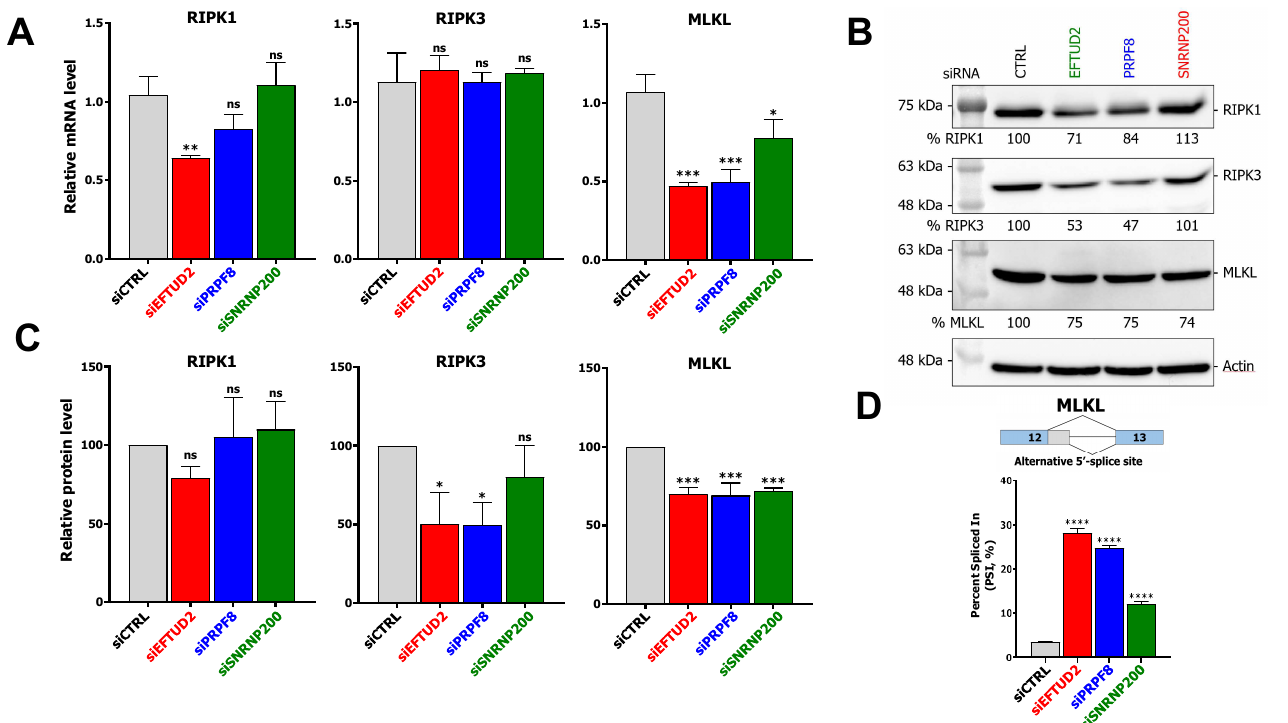
Figure S4). These results establish U5 snRNP proteins EFTUD2, PRPF8, and SNRNP200 as important for the regulation of the mRNA levels, the protein levels, and the AS of key necroptotic proteins RIPK1, RIPK3, and MLKL.